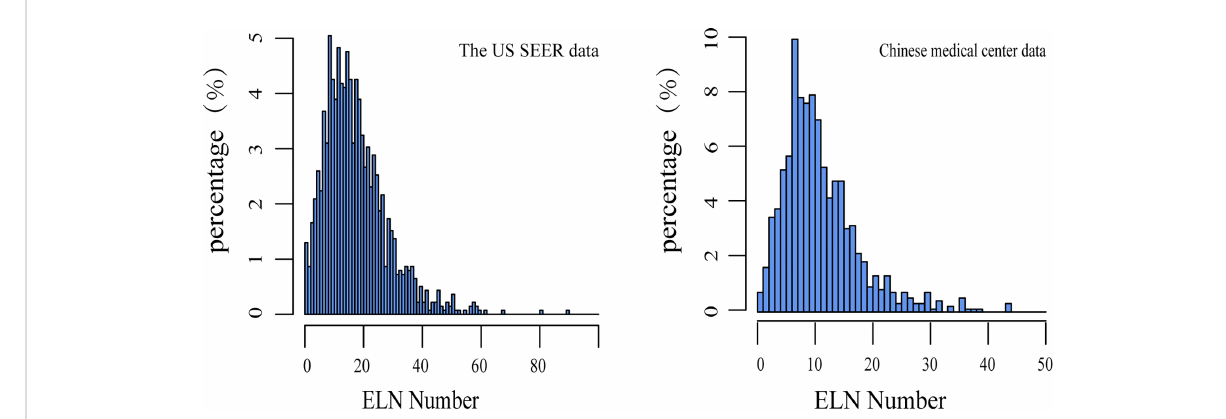
FIGURE 1 Distribution of the number of ELNs in the US and Chinese data. ELN, Examined lymph node.